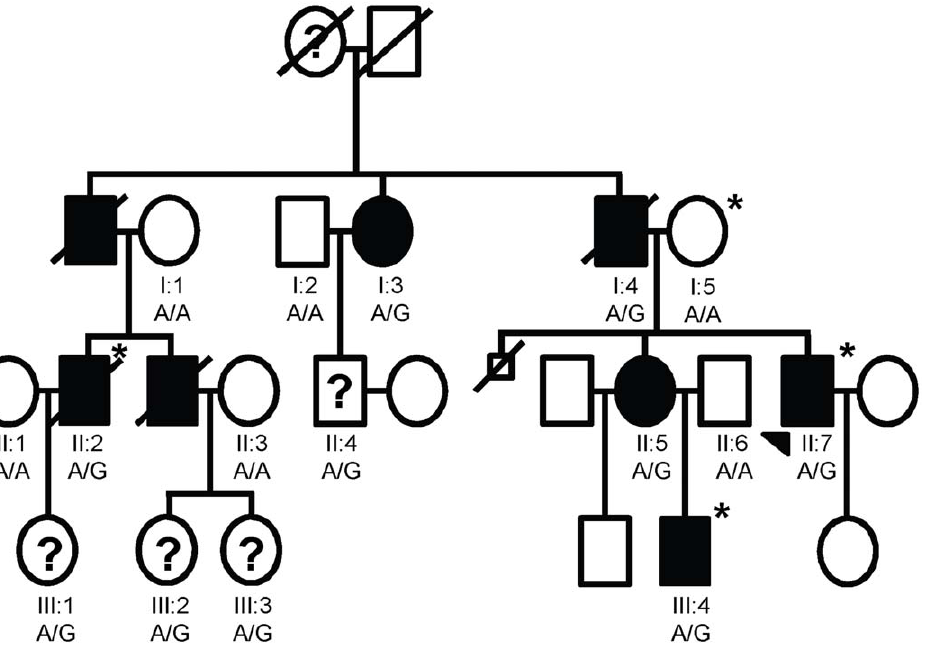
Figure 1. LGMD2359 pedigree and results of Sanger sequencing for DES IVS3 + 3A . G. The pedigree shows the affection statuses, individual identifiers, and genotypes at DES IVS3 + 3. The genotypes obtained through Sanger sequencing of individuals with available high quality DNA are shown. The arrow indicates the proband. * indicates that DNA was sent for exome sequencing. Individuals with ? were of uncertain affection status.